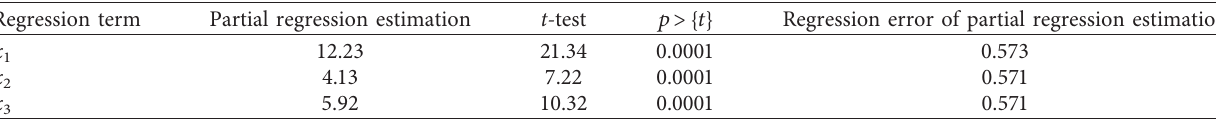
Table 8: Estimation of the partial regression coefficient of y modified with raw soil.